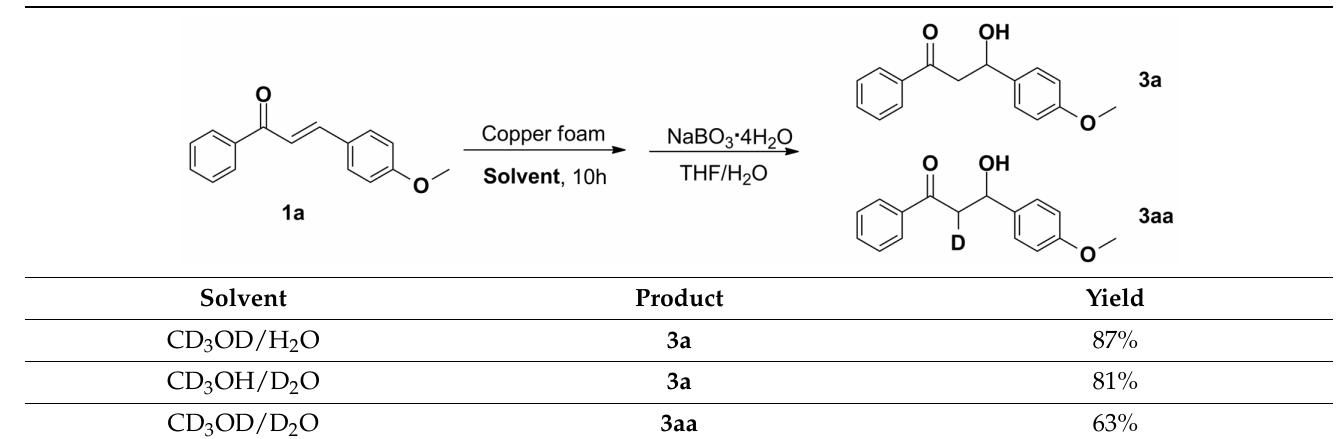
Table 3. Deuterated experiments of 4-methoxychalcone.